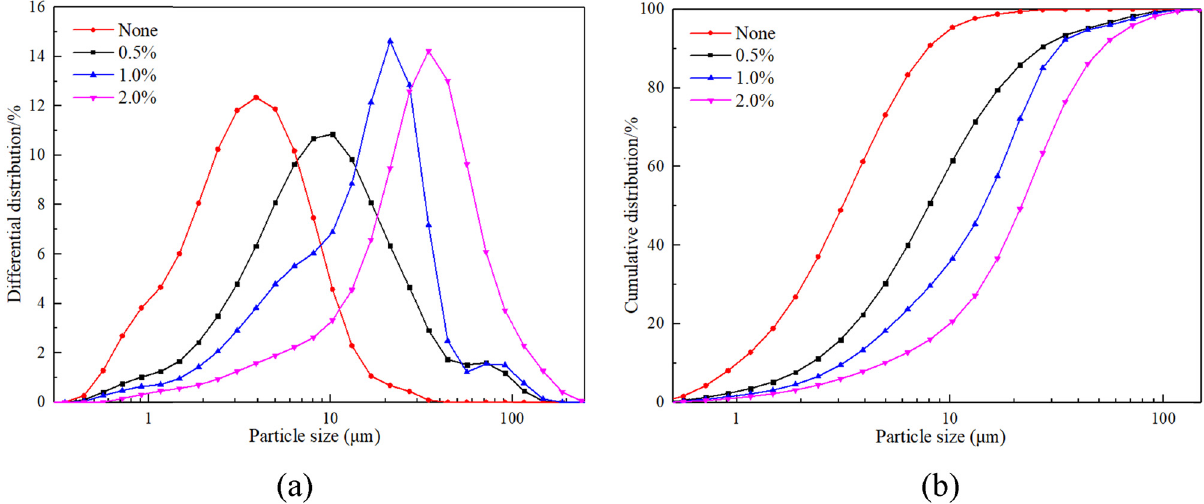
Figure 6: The e ff ect of RH - β - CD on the particle size distribution of bentonite slurry at di ff erent dosages: ( a ) di ff erential distribution and ( b ) cumulative